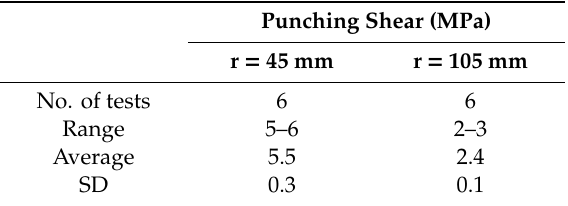
Table 17. Punching shear average value and standard deviation.